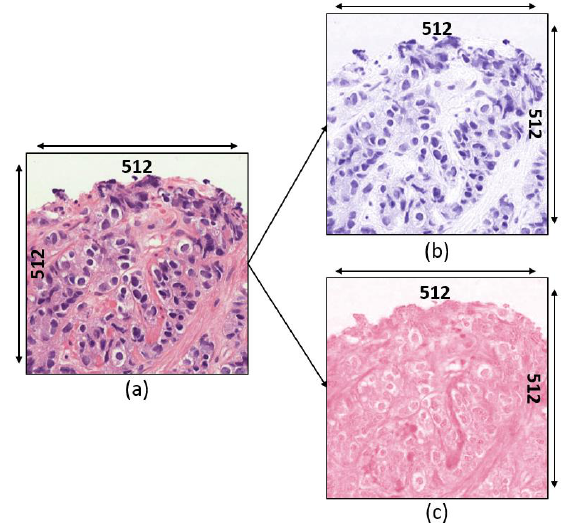
where I O is the background brightfield (i.e., the intensity of light entering the image).